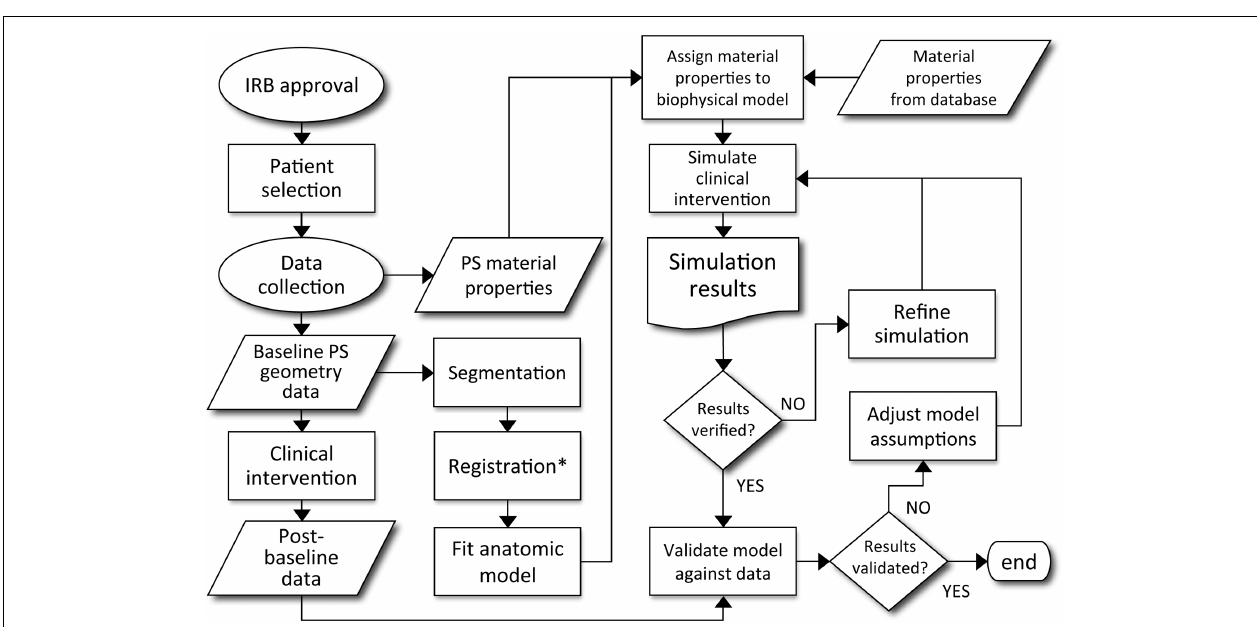
FIGURE 3 | Decision process for patient-specific model validation and translation to clinically applicable analysis. Courtesy: Neal and Kerckhoffs (2010), by permission of Oxford University